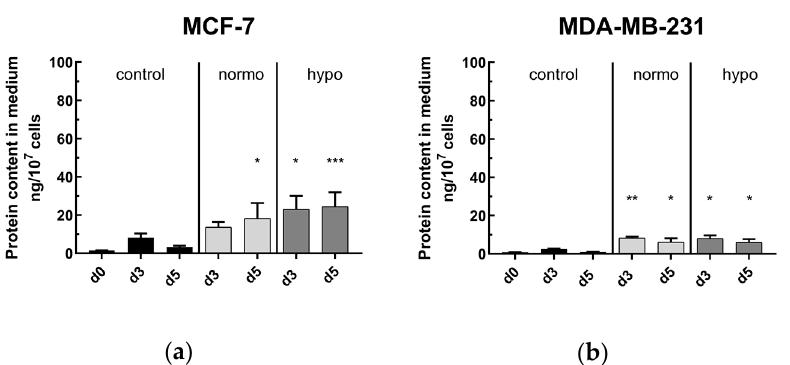
Figure 4. Analysis of danger signal HSP70 in the supernatant of ( a ) MCF-7 and ( b ) MDA-MB-231 breast cancer cells after normo- and hypofractionated radiotherapy. Cells were irradiated either by normofractionation (normo) at single doses of 2 Gy or by hypofractionation (hypo) at single doses of 5 Gy and analyzed on day 3 (d3) and day 5 (d5). The protein content of the danger signal HSP70 was analyzed by sandwich ELISA and is related to 1 × 10 7 cells. Mean ± S.D. are presented from at least three independent experiments, each measured in duplicates. Significance test was conducted using Kruskal-Wallis test with uncorrected Dunn´s multiple comparison, by comparing the protein content of the respective irradiation treatment to the corresponding controls of mock-treated cells at the indicated time points (d3, d5); * ( p < 0.1), ** ( p < 0.01), *** ( p < 0.001).